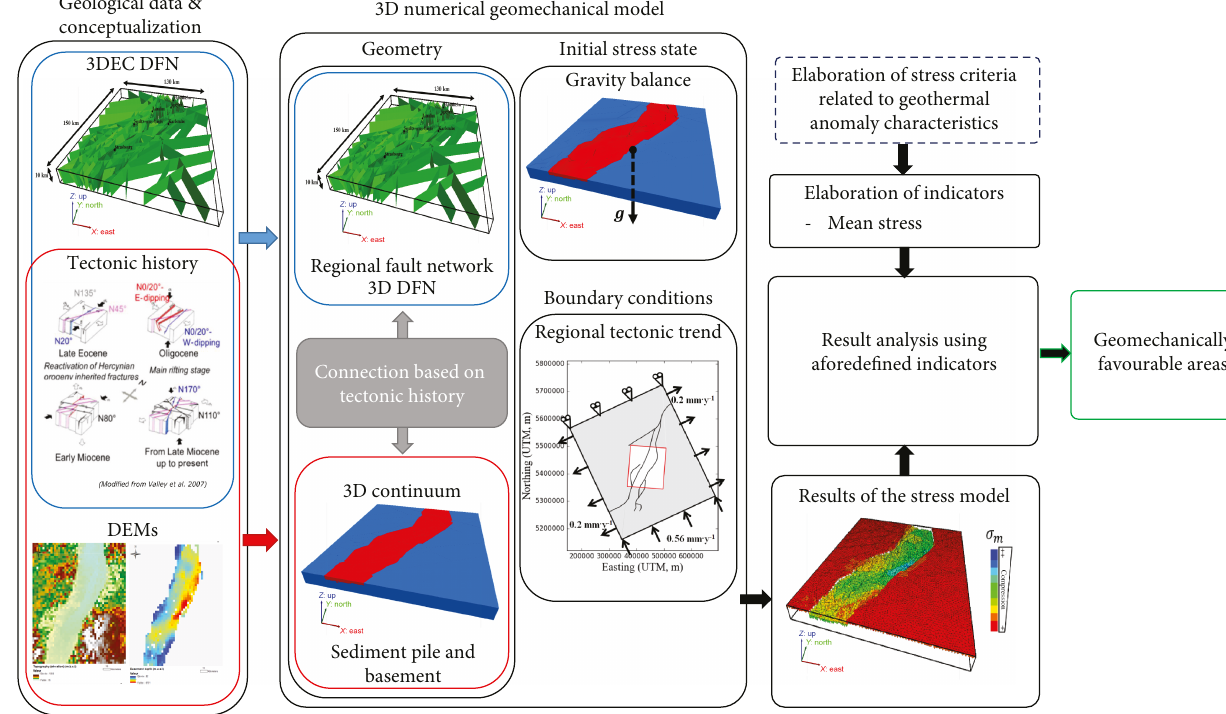
Figure 7: Main steps of the geomechanical simulations (from data to delineation of preferential